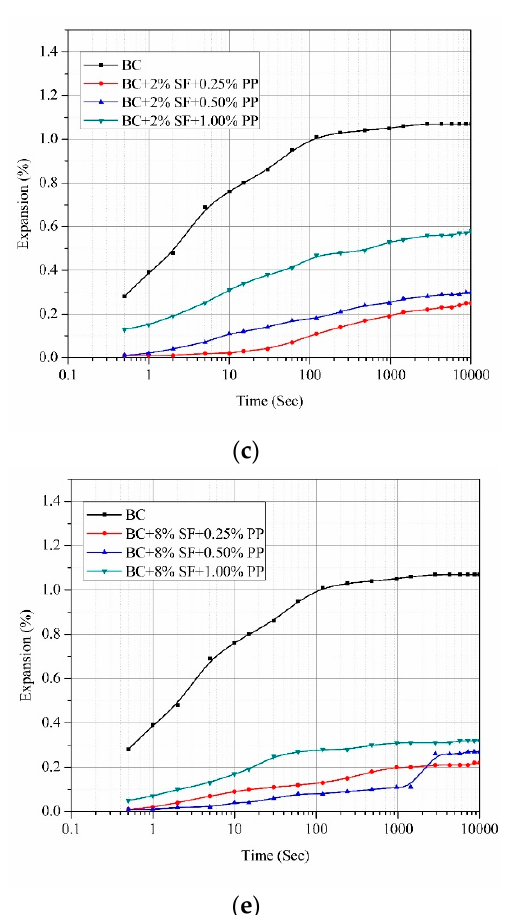
Figure 4. ( a ) Expansion rate curves for silica fume-reinforced expansive soil. ( b ) Expansion rate curve for polypropylene fiber-reinforced expansive soil. ( c ) Expansion rate curve for polypropylene fiber reinforced with 2% silica fume expansive soil. ( d ) Expansion rate curves for polypropylene fiber reinforced with 4% silica fume expansive soil. ( e ) Expansion rate curves for polypropylene fiber reinforced with 4% silica fume expansive soil.